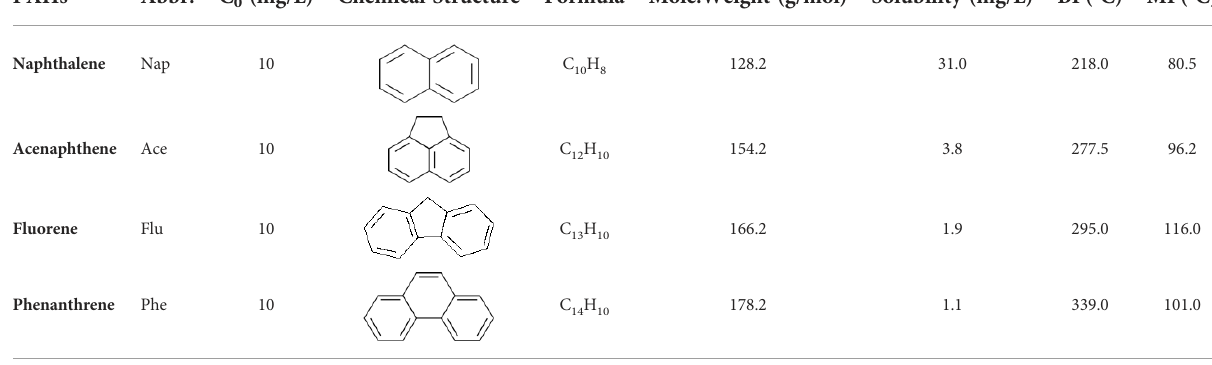
TABLE 1 Physical-chemical properties of selected PAHs (Mackay and Callcott,